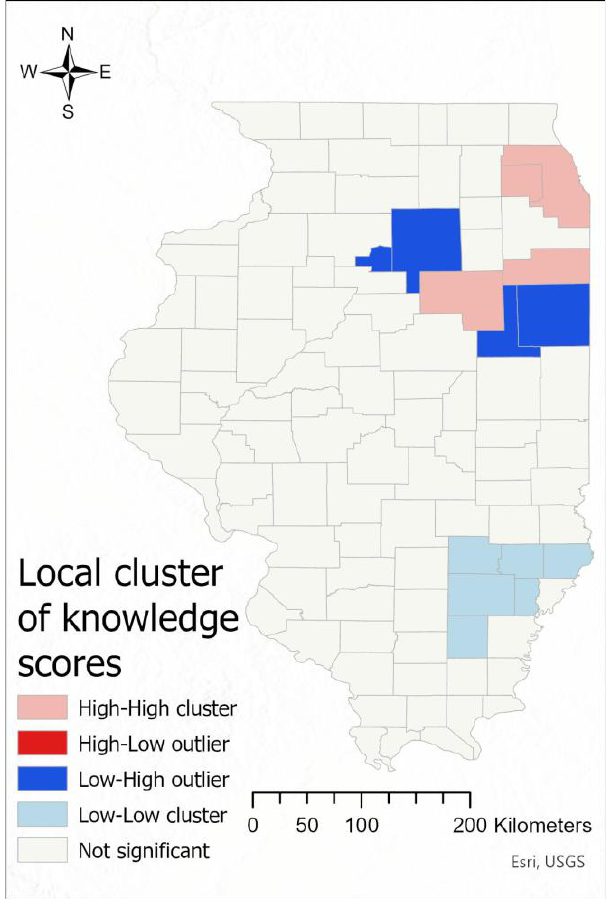
Figure 7. Cluster and outlier (local Moran’s I) analysis result of survey knowledge scores.